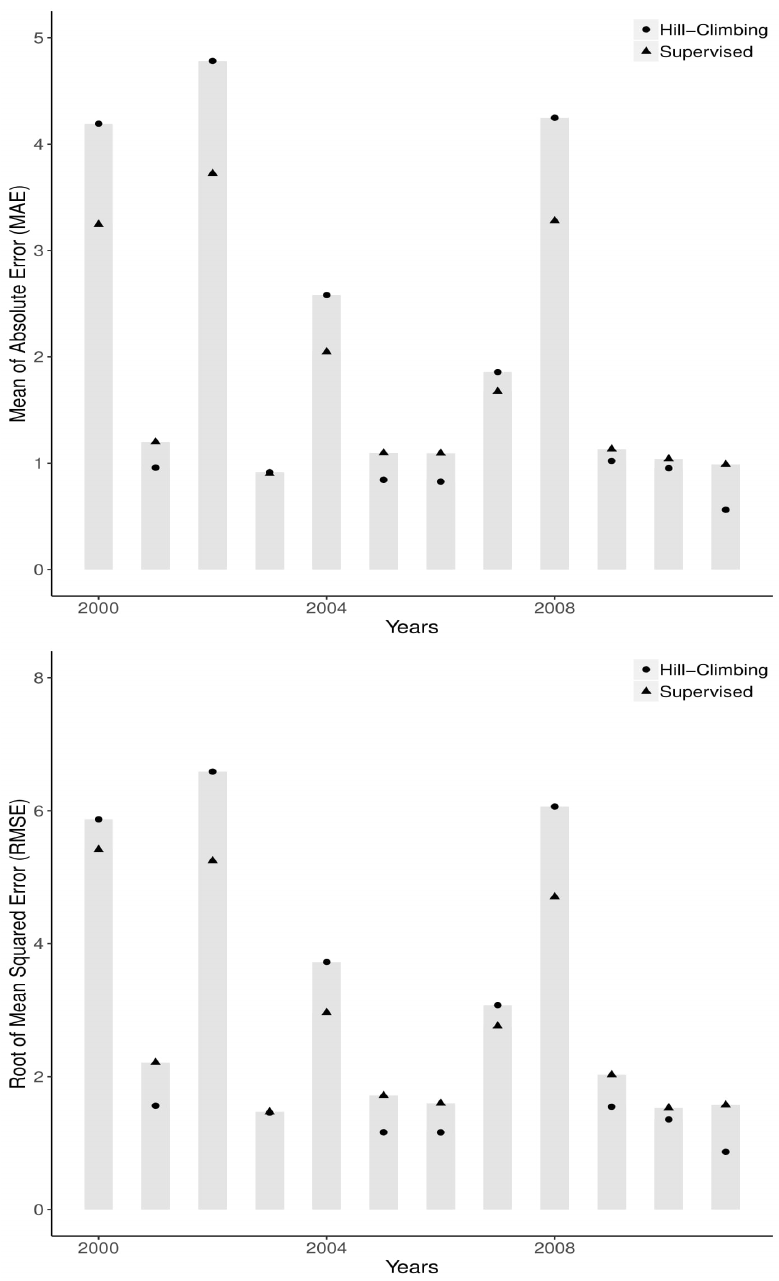
Figure 8. Model forecast skill from k -fold cross-validation (2000–2010) and 2011 year validation in both supervised (circle) and hill-climbing based algorithmic learning (triangle). MAE and RMSE were computed for the three susceptible grape cultivars in the testing year. Smaller values in both MAE and RMSE indicates higher forecast